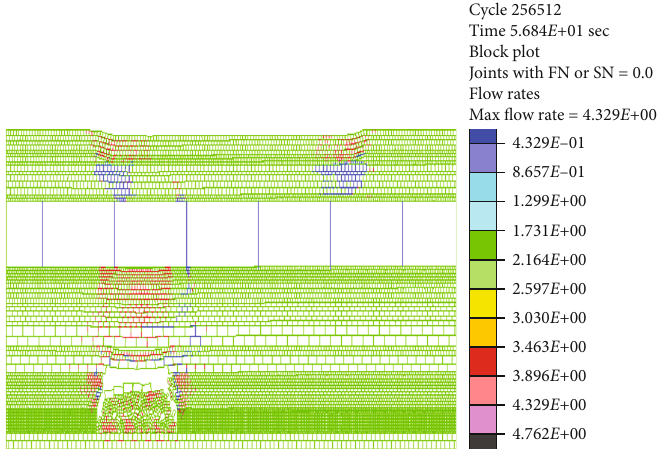
Figure 7: The fl ow distribution in initial caving of key layer 1.